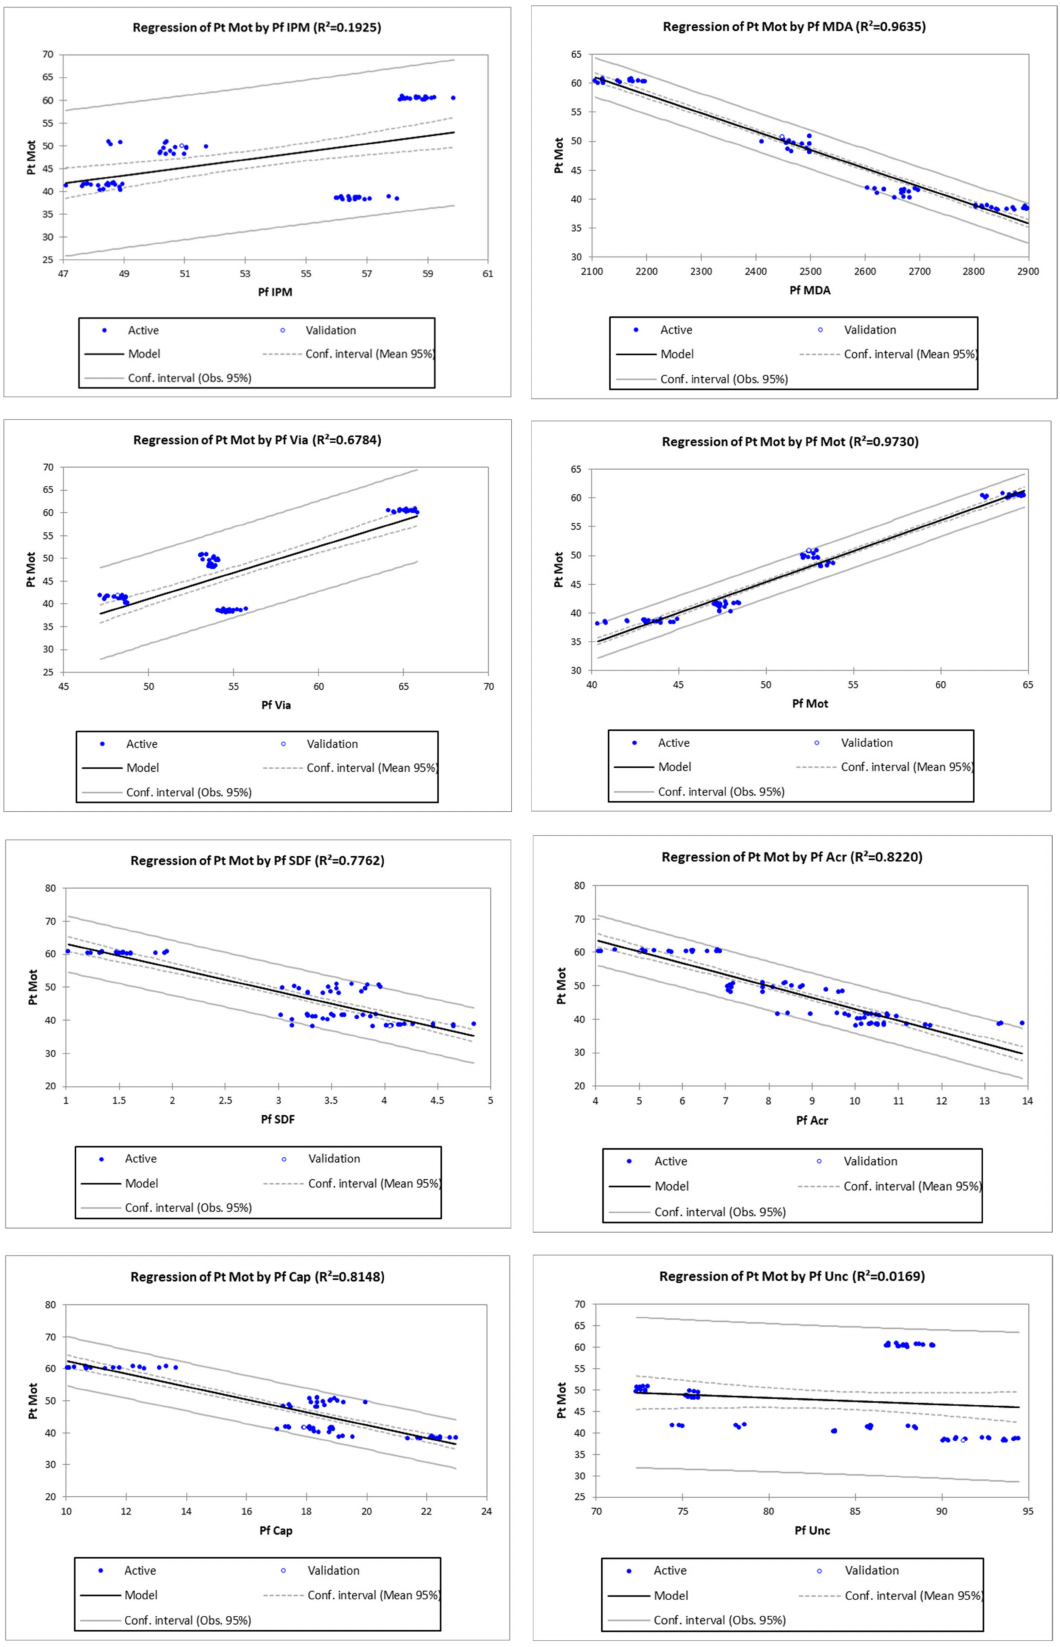
Figure 2. Linear regression curve of the post-thawed semen motility (Y) based on pre-freezing parameters